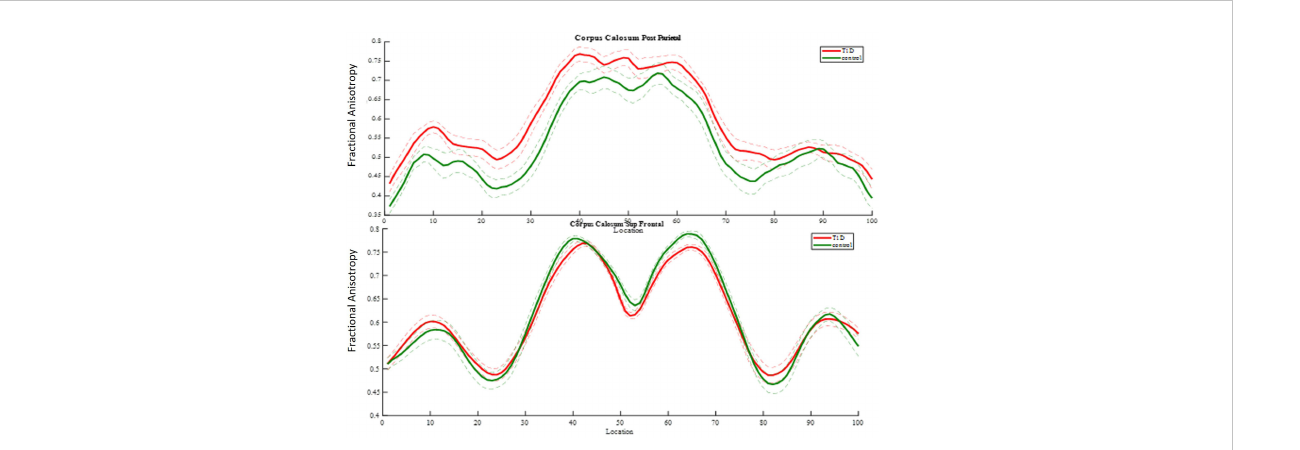
FIGURE 8 FA group comparison plots. Control group and diabetes mean FA ± 1 SD is plotted along 100 nodes on tract center. The upper graph shows signi fi cantly higher FA values in the diabetes group in 32 locations of the posterior parietal callosal segment. The panel beneath it shows signi fi cantly lower FA values in the diabetes group in 12 locations of the superior frontal callosal